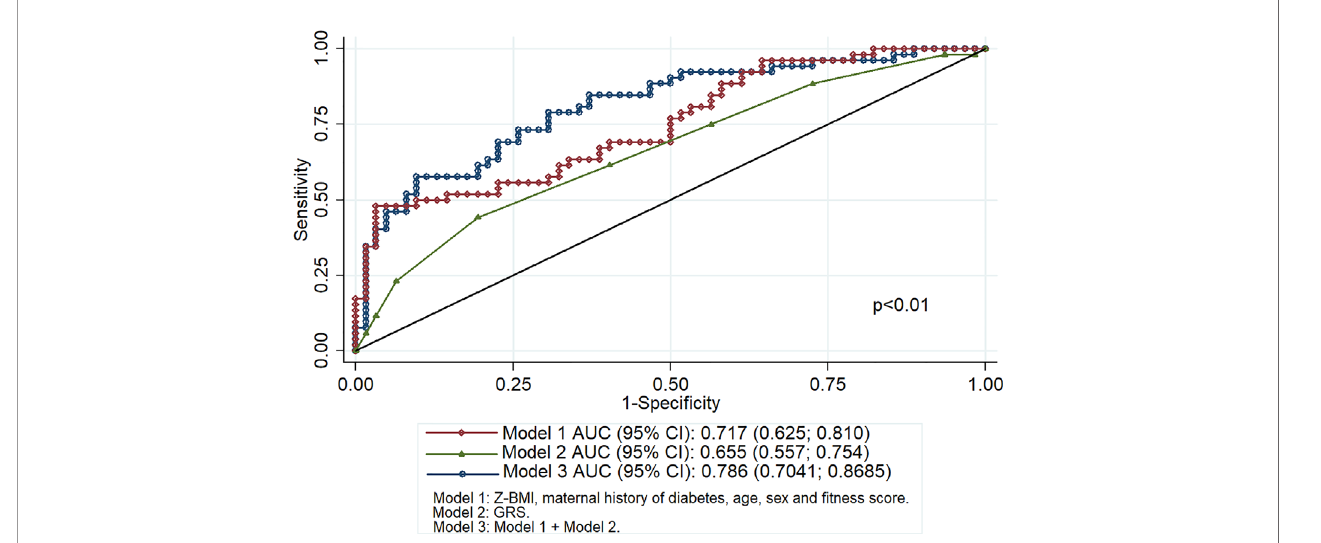
FIGURE 3 | Area under the receiver operating characteristic curve for pediatric-onset type 2